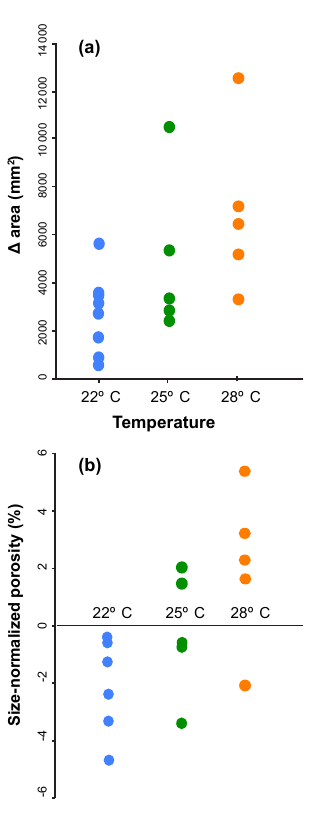
Figure 5. Total test area and final chamber porosity of each cultured specimen of Globigerinoides ruber grouped by treatment tempera- ture for (a) the total change in area before and after the experiment, and (b) size-normalized porosity of the final